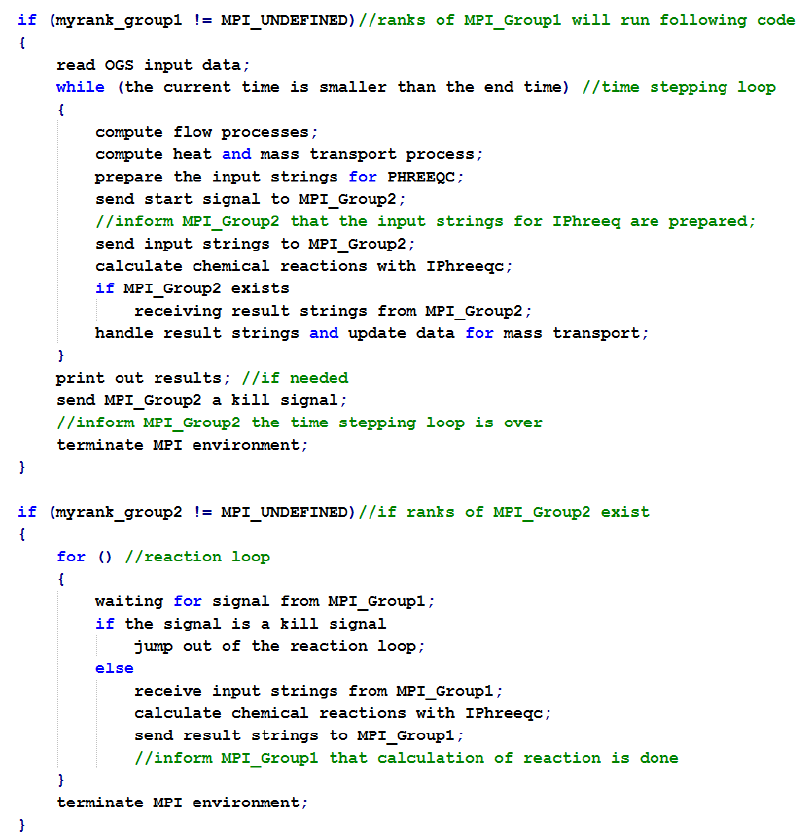
Figure 6. Pseudo-code for schematic presentation of the parallelization